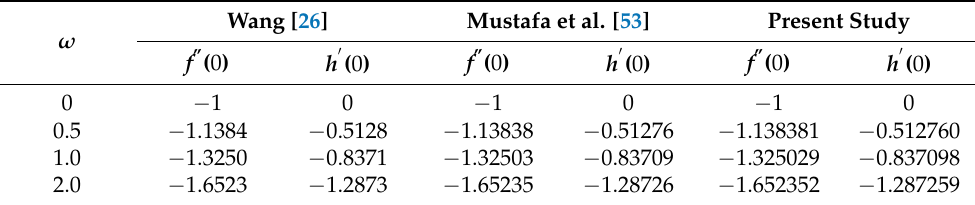
Table 2. Comparison values of f (cid:48)(cid:48) ( 0 ) and h (cid:48) ( 0 ) for multiple values of rotation parameter ω when ε = ϕ = S = 0 and Pr = 6.2 (water) for SWCNT. Wang [26] Mustafa et al. ω